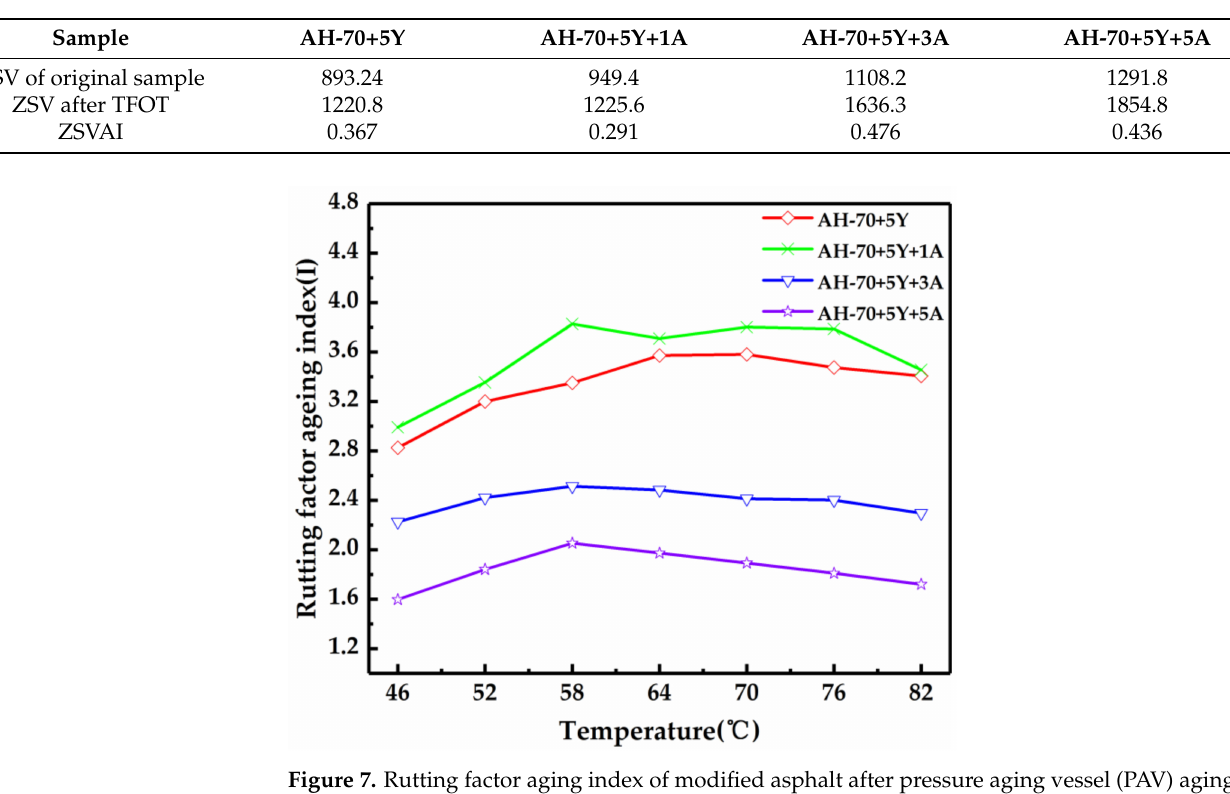
Figure 6. Rutting factor aging index of modified asphalt after TFOT aging. Table 7. Zero shear viscosity (ZSV) aging index of modified asphalt after TFOT aging.